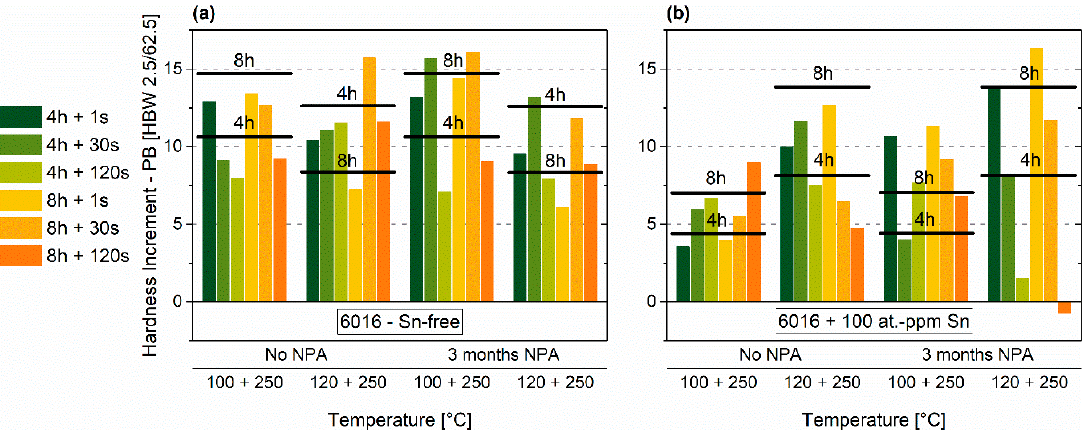
Figure 12. Paint-bake response (185 °C, 20 min, no pre-deformation) of samples treated according to PA3 (no NPA) and PA3’ (3 months of NPA before applying Spike II) (pre-annealing - first temperature in the axis label + Spike II - second temperature in the axis label) for EN-AW-6016 Sn-free ( a ) and EN-AW-6016 + 100 at.-ppm Sn ( b ). The horizontal black lines mark the paint-bake response of sole pre-annealing at 100 °C and at 120 °C.